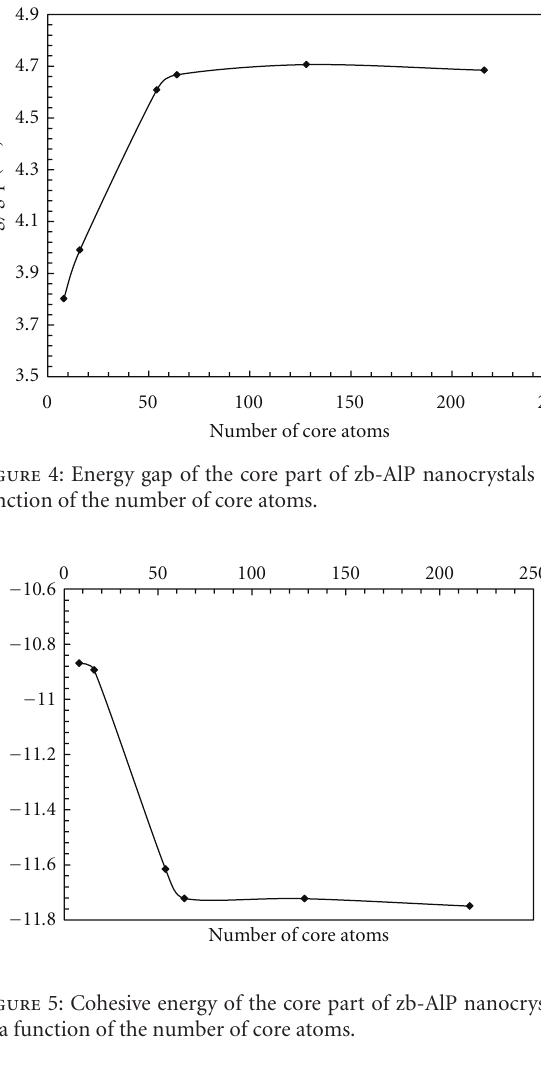
Figure 3: Bulk modulus as a function of the number of core atoms.